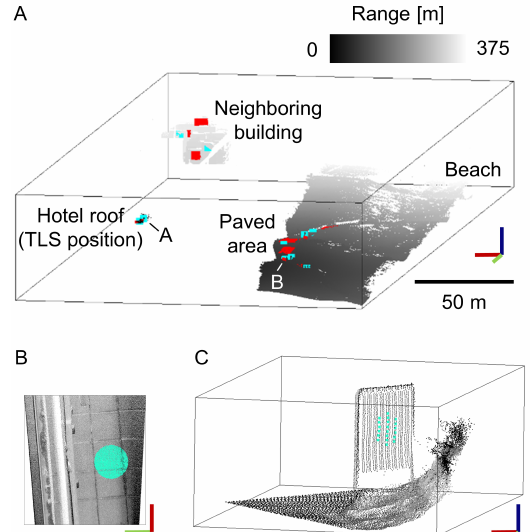
Figure 3. (A) Extract of the point cloud scene colored by range with stable parts used for fine alignment (red) and control planes (blue). Below, exemplary control planes are shown (B) on the tiled floor near the scanner and (C) on an information sign next to the dunes Measurements with a Global Navigation Satellite System